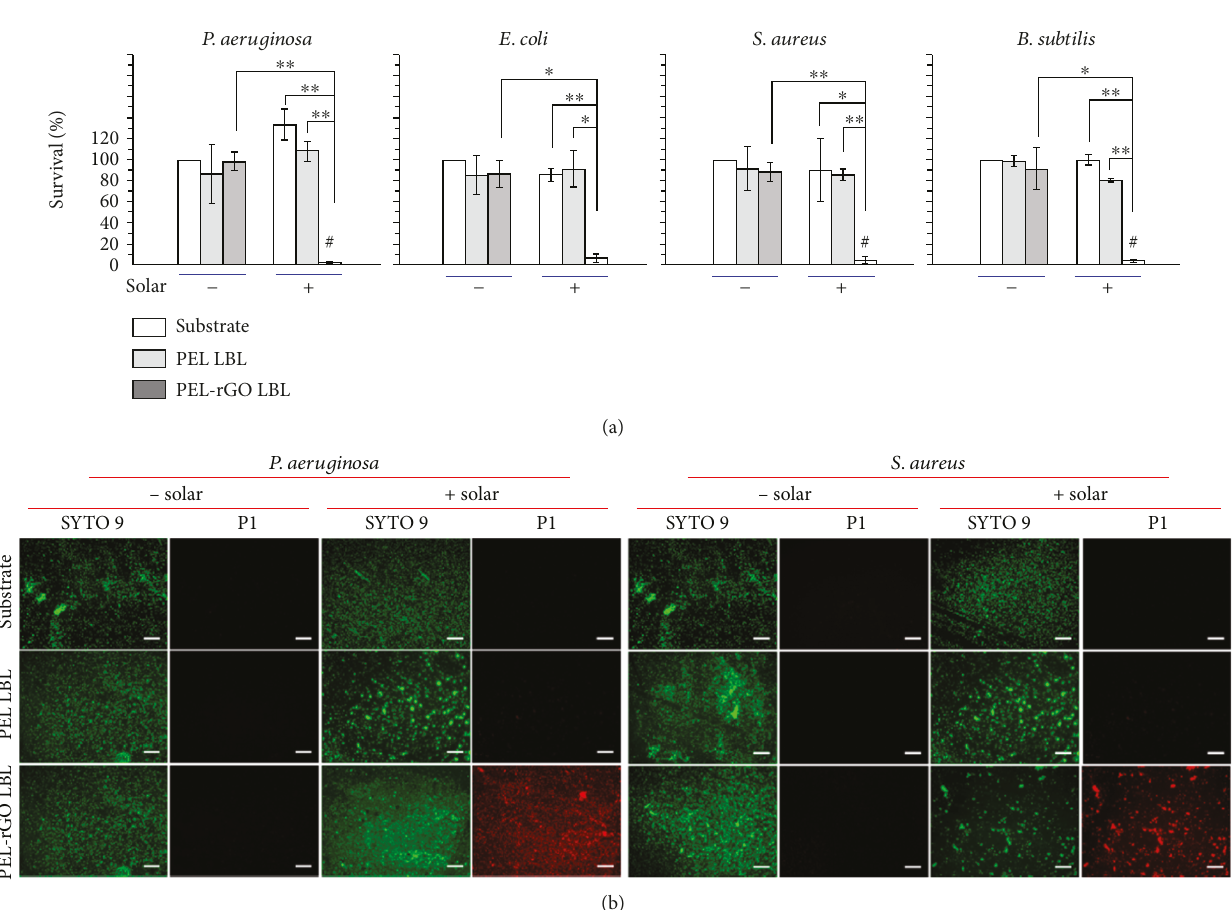
Figure 12: (a) CFU-counting antibacterial assays against four wild-type (wt) bacterial strains consistently reveal that the PEL-rGO LBL thin fi lm, though barely bactericidal when in the dark, killed > 90% airborne bacteria on contact within 10min upon solar irradiation (AM 1.5G, at one sun). In contrast, the PEL LBL multilayer barely a ff ected bacterial survival no matter whether solar irradiation was applied or not, similar to the behavior of the bare quartz substrate. Data points are reported as mean ± standard deviation. ∗ and ∗∗ indicate p < 0 05 and p < 0 01 , respectively. (b) Bacterial dead/live viability assays under fl uorescence microscopy show that P. aeruginosa and S. aureus cells on a